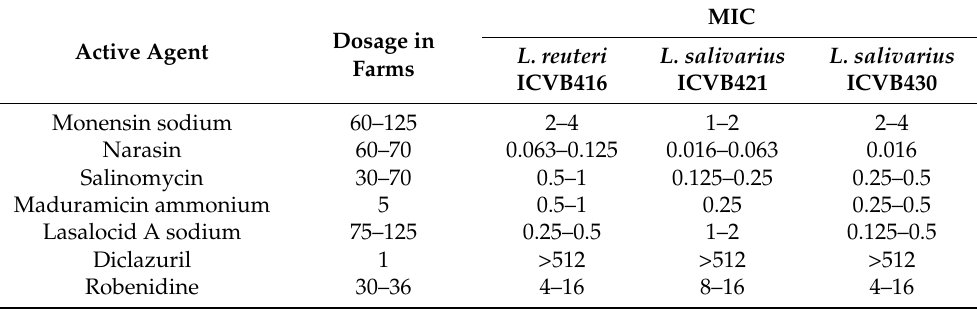
Table 2. Minimal inhibitory concentration (MIC) of coccidiostat usually used in poultry production. Values are expressed in